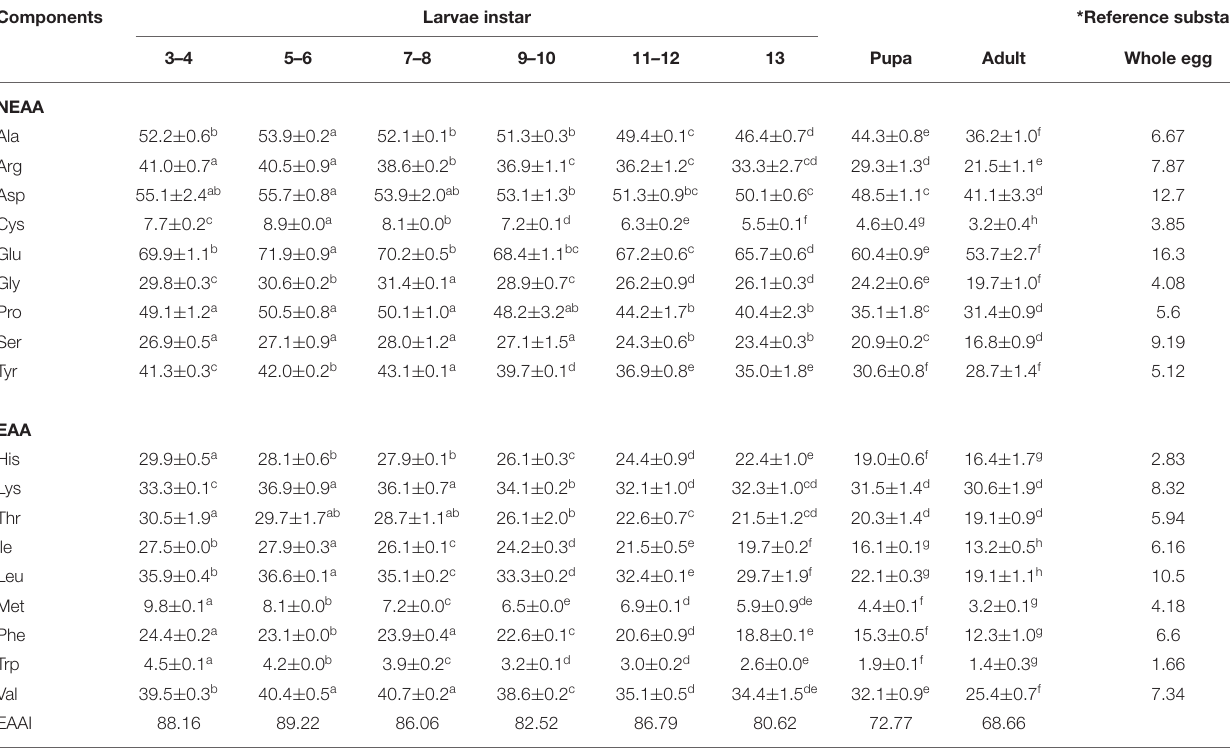
TABLE 3 | Amino acid content at different development stages of Tenebrio molitor (mg/g, dry matter basis).